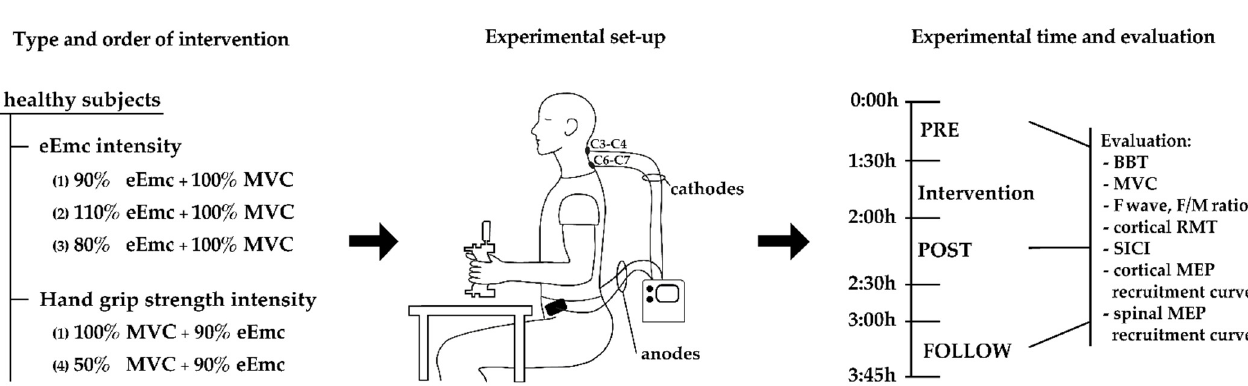
Figure 1. Schematic representation of the experiment conditions, order of intervention and the evaluation time points during each experiment, and the functional and motor strength assessment and neurophysiological assessments per- formed.